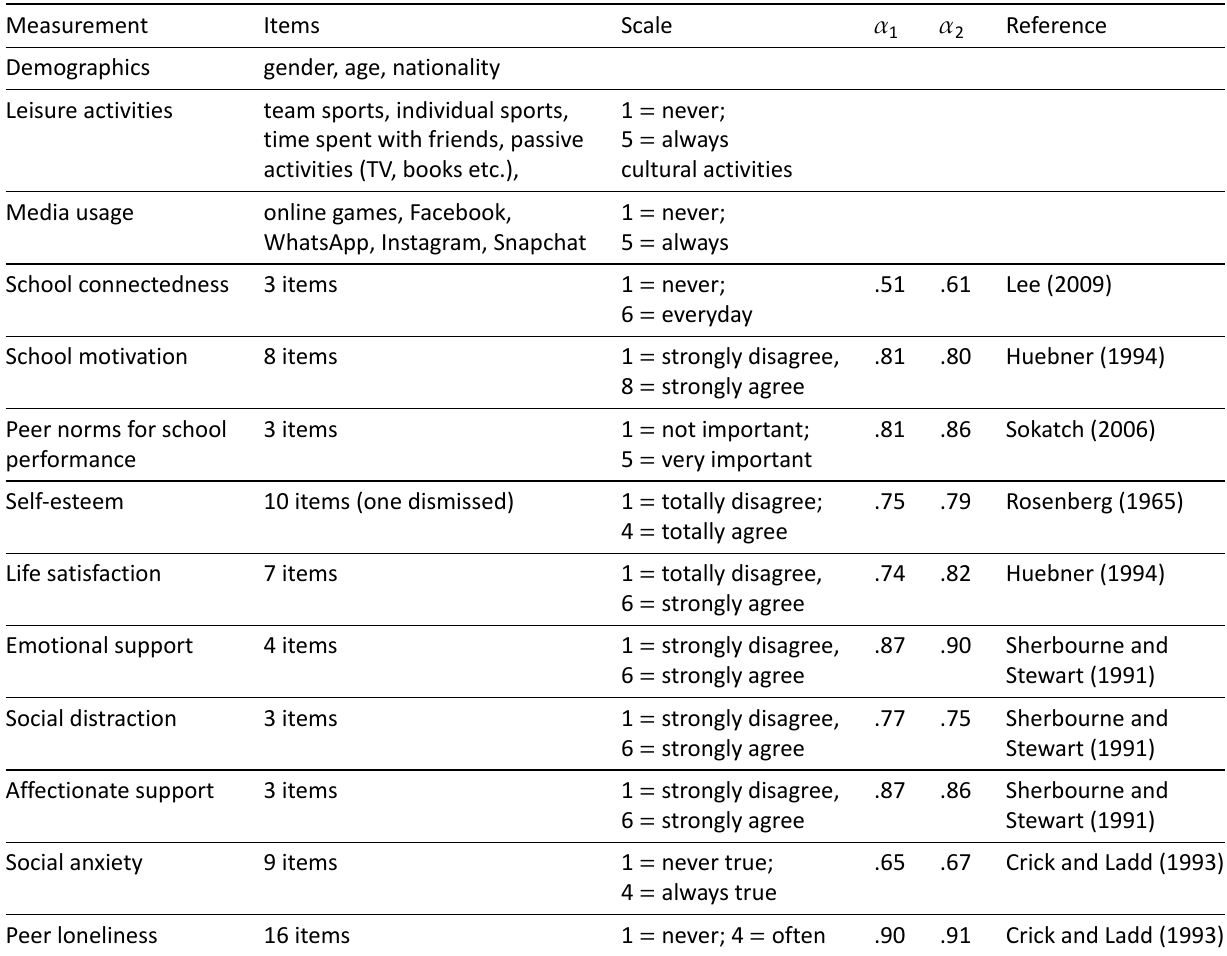
Table 1. Measurements for pre- and